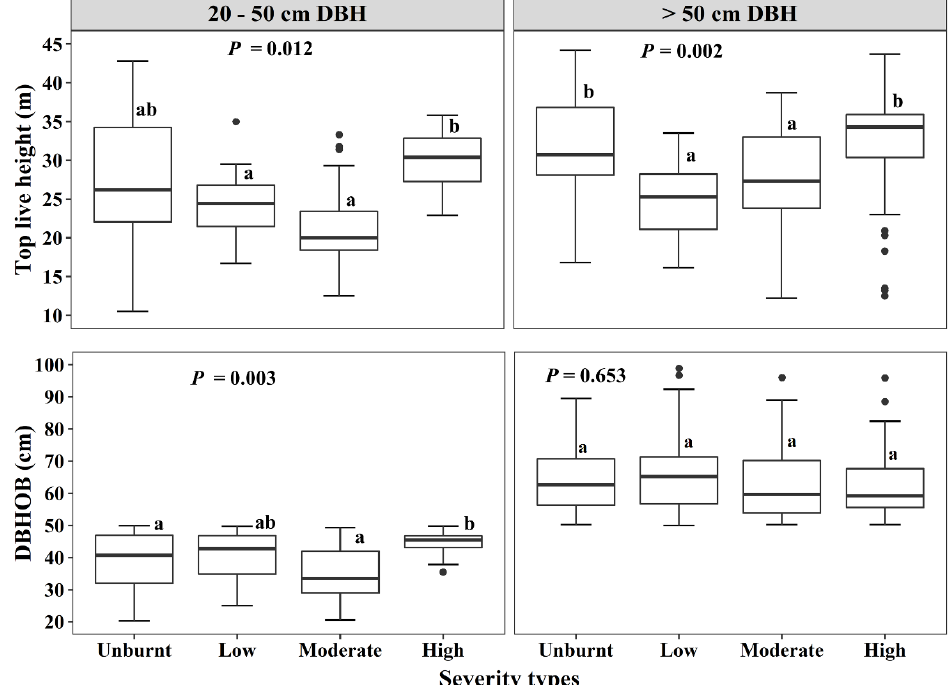
Figure 5. Comparison of top live height and diameter at breast height over bark (DBHOB) of field-measured trees among fire-severity types for both mature (20 – 50 cm DBHOB) and over-mature trees (>50 cm DBHOB). Graphs are standard boxplots (median as centre line), based on 20 to 59 trees per diameter class for each severity (20 – 50 cm: unburnt (UB) — 34; low severity (L) — 51; moderate severity (M) — 49; high severity (H) — 20; >50 cm: UB — 45; L — 40; M — 44; H — 59). P-values are calculated from linear mixed effects models (LMEM), and different letters indicate significant differences between fire-severity types as indicated by post hoc tests (Fisher’s LSD test).